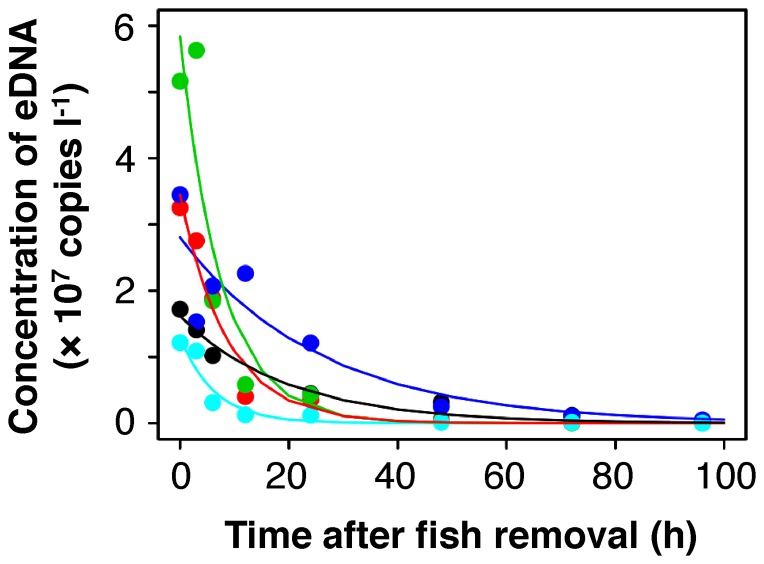
Time-dependent changes in the eDNA concentration after fish removal.Regression curves of the non-linear models are shown. Each color indicates one of five individuals (black and aqua: adult, others: juvenile).